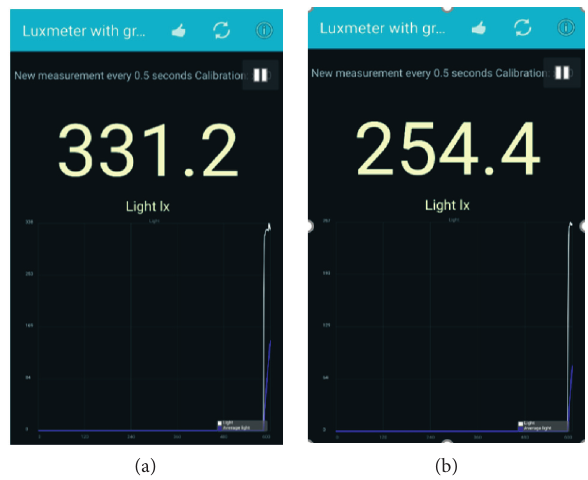
Figure 4: View of a blank sample (a) and a sample containing 0.5 g · L − 1 BSA-normal saline solution (b) through the Luxmeter with graph application on a